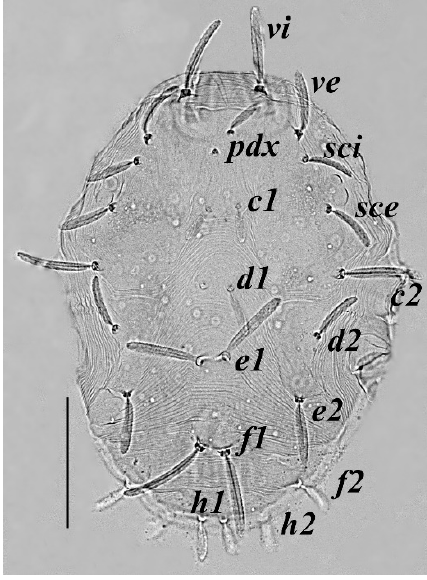
Figure 19. Neophyllobius muscantribii . Female. Dorsum. Scale bar: 100 μ m.